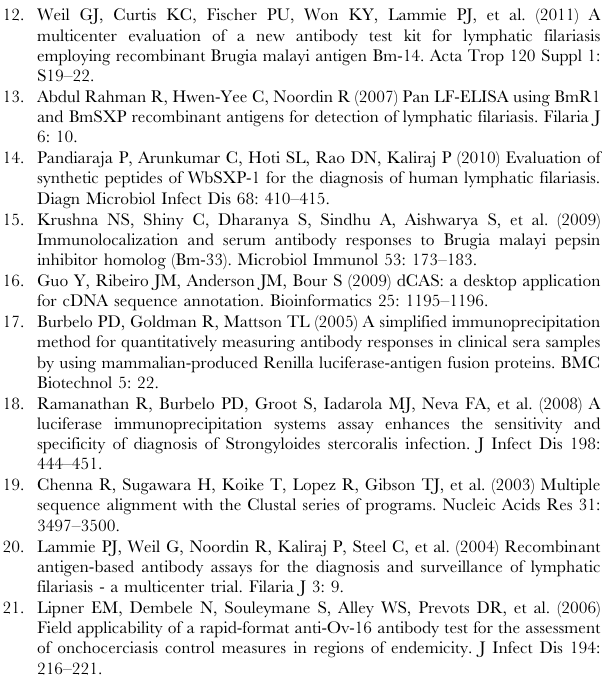
Table S2 Composition of serum samples used for blinded analyses of IgG anti-Wb123 LIPS